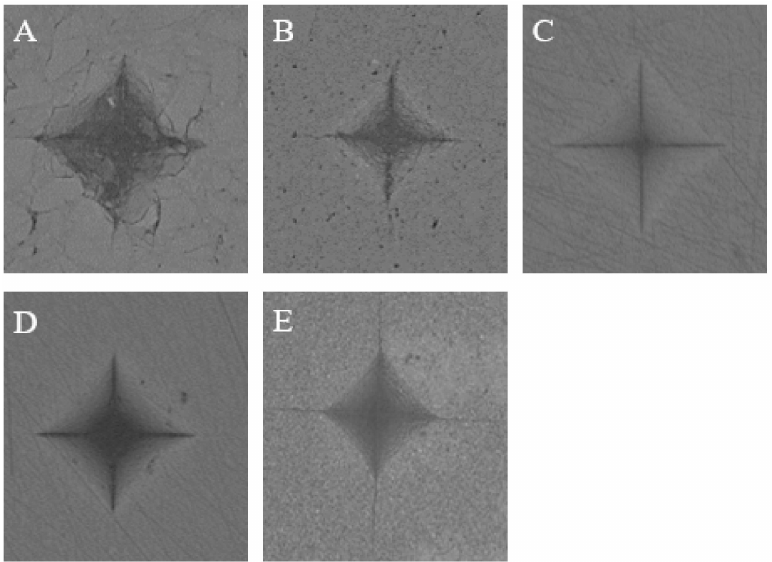
Figure 5. Typical Vickers hardness indentation image of the specimens’ surfaces: ( A ) Amber Mill Hybrid (AH); ( B ) Vita Enamic (VE); ( C ) Katana Avencia (KA); ( D ) Lava Ultimate (LU); ( E ) Amber Mill